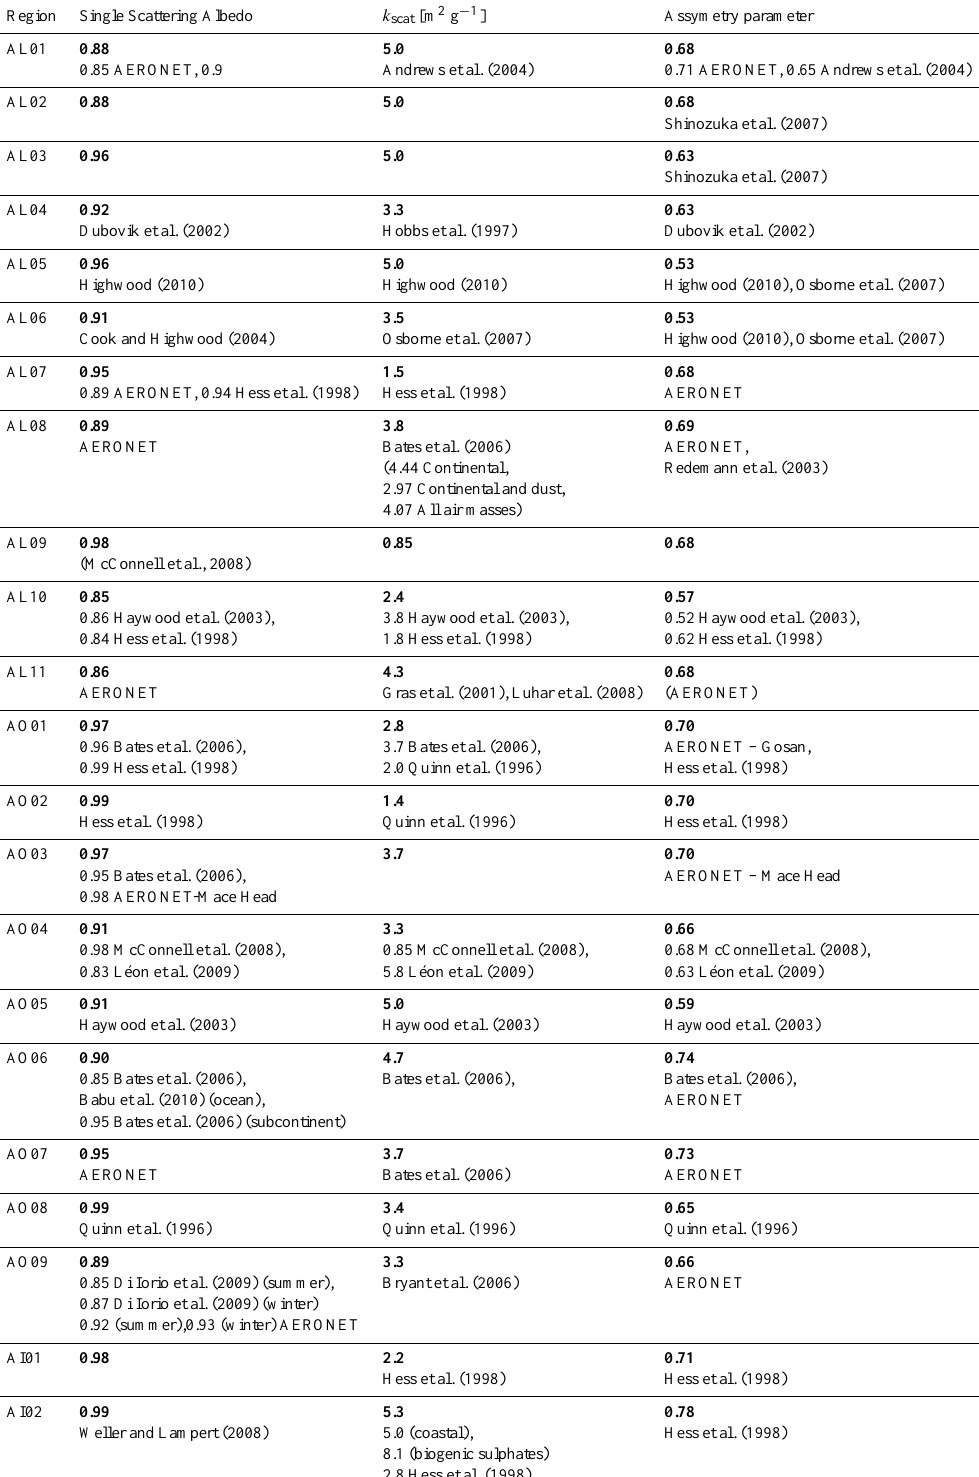
Table 3. Aerosol scattering properties used in this study for each region, and their literture sources. Where two or more different properties are found, an average is